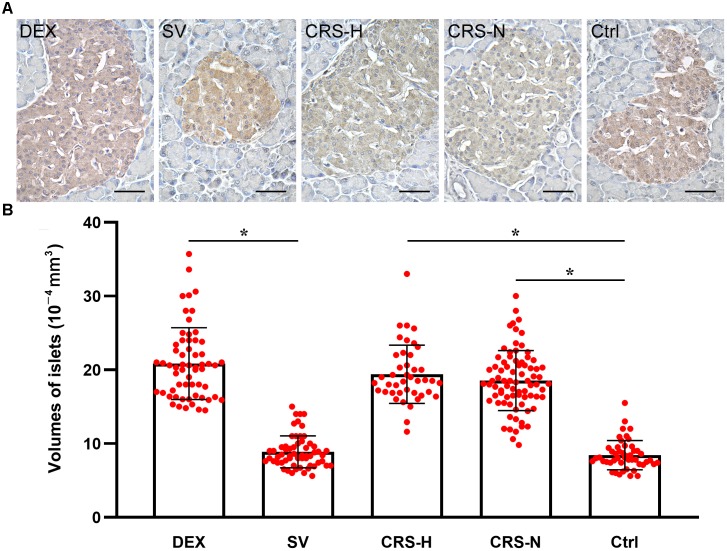
Insulin immunoreactivity and average volume of islets. (A) Insulin immunohistochemical staining. The islets of CRS-hyperglycemic and CRS-normoglycemic mice had reduced insulin immunoreactivity. The histological structure of islets in each group did not change. Bar = 50 μm. (B) Comparison of average volume of islets. Both DEX injection and CRS can increase islet volume. Islets of both CRS-hyperglycemic and CRS-normoglycemic mice were enlarged. SV, solvent injection; CRS-H, CRS-hyperglycemia; CRS-N, CRS-normoglycemia; Ctrl, normal control. Data in (B) were shown as means ± SEM, ∗p < 0.01.